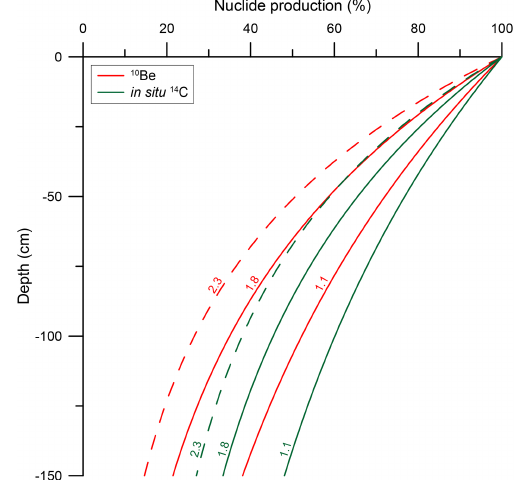
Figure 1. Depth and density dependence of nuclide production (non-eroding surfaces) within homogenous material. Solid lines represent two endmember densities (1.1 and 1.8gcm − 3 ; e.g. Hartel, 2005; Manrique and Jones, 1991; Schaetzl and Thompson, 2015) of typical soils (red: 10 Be; green: in situ 14 C). Dashed lines re- flect nuclide production for highly compacted soils (2.3gcm − 3 ; Schaetzl and Thompson, 2015). Calculated for SLHL using the LSDn (Sa) scaling scheme (Lifton et al., 2014) with a spallogenic production rate of 3 . 92 ± 0 . 31atg − 1 yr − 1 for 10 Be and 12 . 76 ± 0 . 00atg − 1 yr − 1 for 14 C (Borchers et al., 2016; Phillips et al., 2016) and including the contribution of muogenic production as imple- mented in the MATLAB code provided by Balco